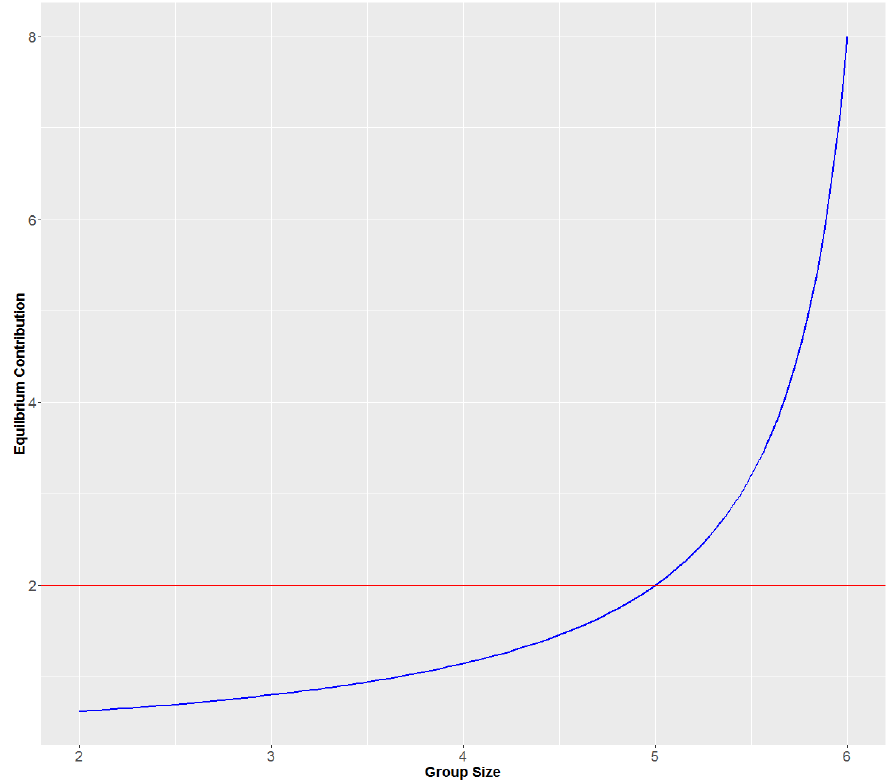
Figure 2. The equilibrium action as a function group size: linear baseline treatment (red) and treatment with complementarities